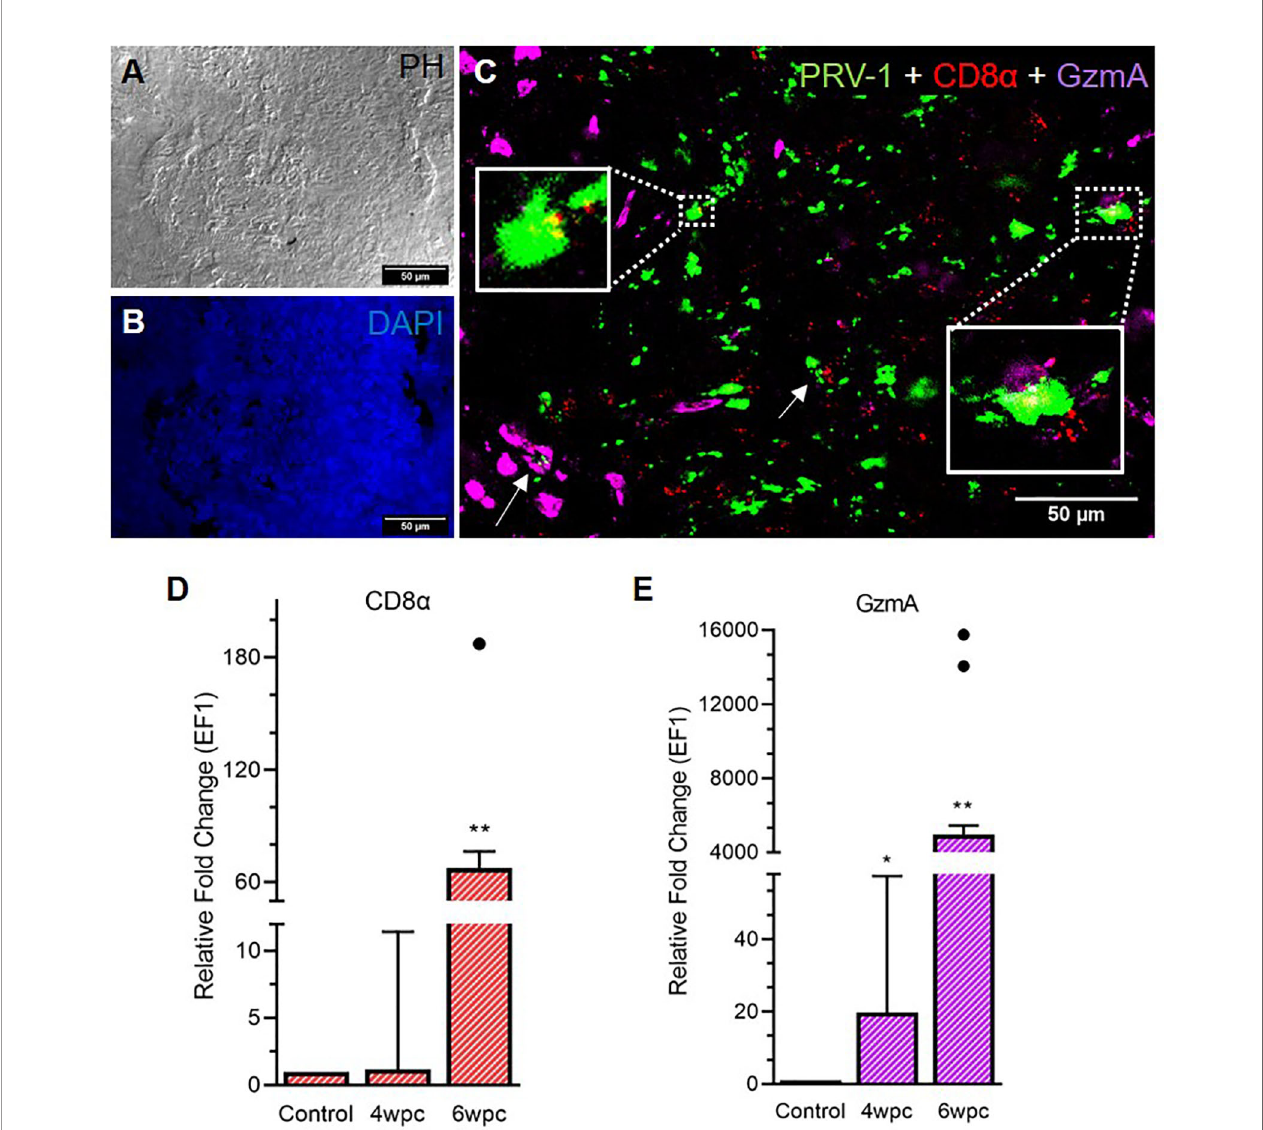
FIGURE 3 | Fluorescent in situ hybridization (FISH) of PRV-1, CD8 a and GzmA in heart tissue at peak of HSMI associated histopathological changes (6 wpc). (A) Phase contrast image showing blood cells in the spongiosum. (B) Nuclei stained with DAPI (Blue). (C) Merged image showing co-localization of PRV-1 (green) with CD8+ (red) cells and cells expressing GzmA (purple) (arrows, yellow in inserts). GzmA stained cells were prominent in areas with dense PRV-1 staining (Scale Bar = 50 µm). (D, E) Relative fold change expression (medians) of CD8 a and GzmA at 4 wpc and 6 wpc normalized against EF1 a . Dots show outlier values in the respective group of fi sh. (*) shows signi fi cant difference from the control (*p < 0.05, **p <